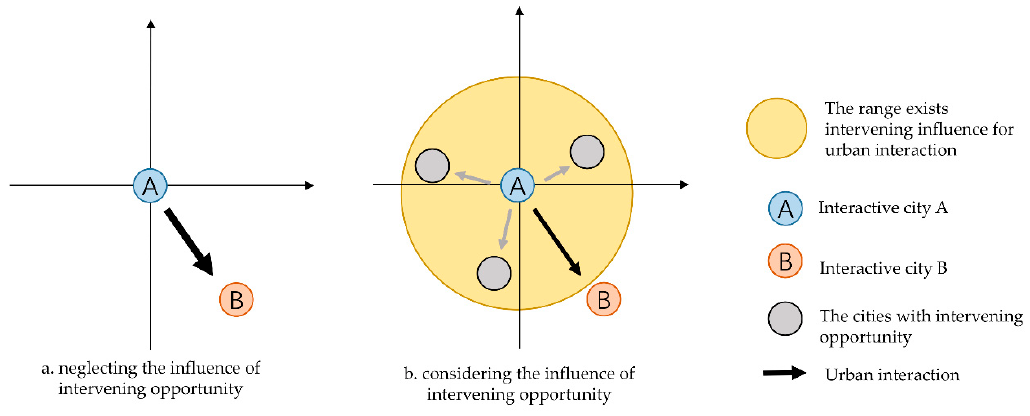
Figure 2. Expression of urban interactions without and with intervention.